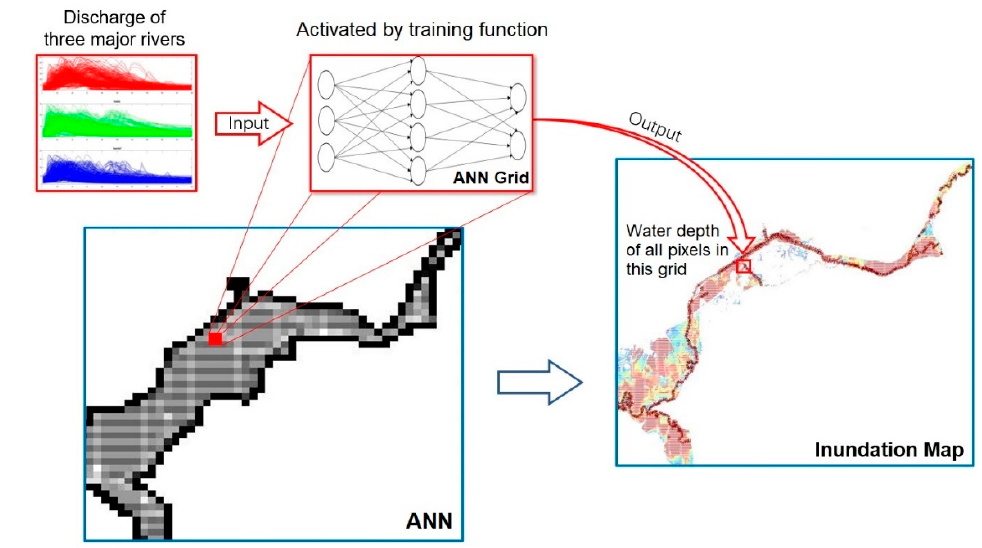
Figure 1. Structure and mechanism of each ANN for maximum flood inundation area forecasting.